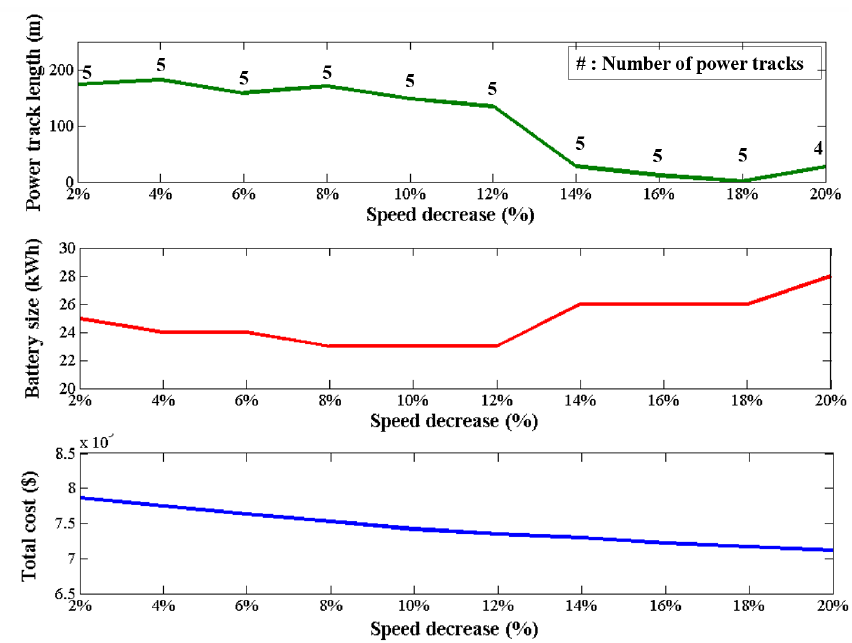
Figure 15. Sensitivity analysis of the decrease in vehicle speed.